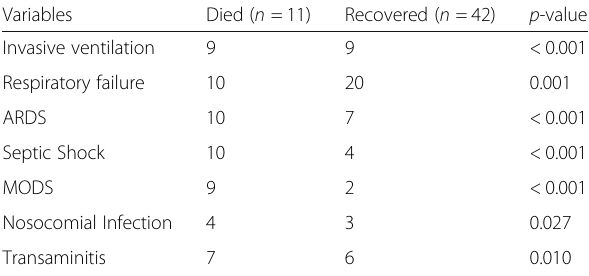
Abbreviations: ARDS Acute Respiratory Distress Syndrome; MODS Multi-organ dysfunction